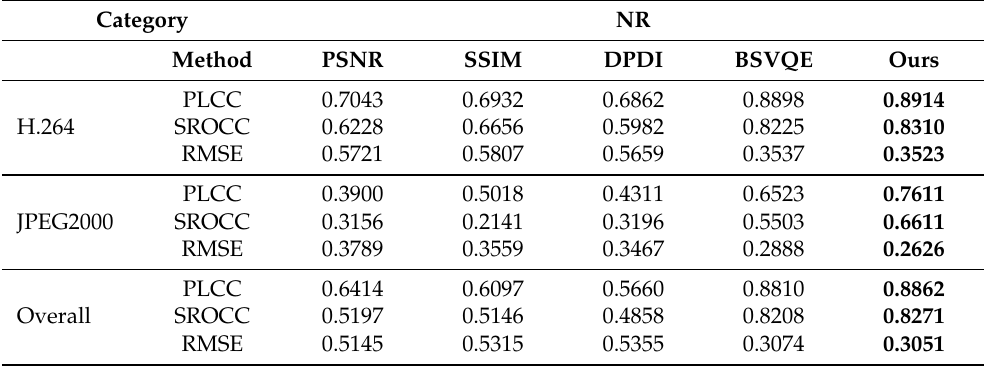
Table 2. Performance comparison of various methods on the SIAT database. The best results are in